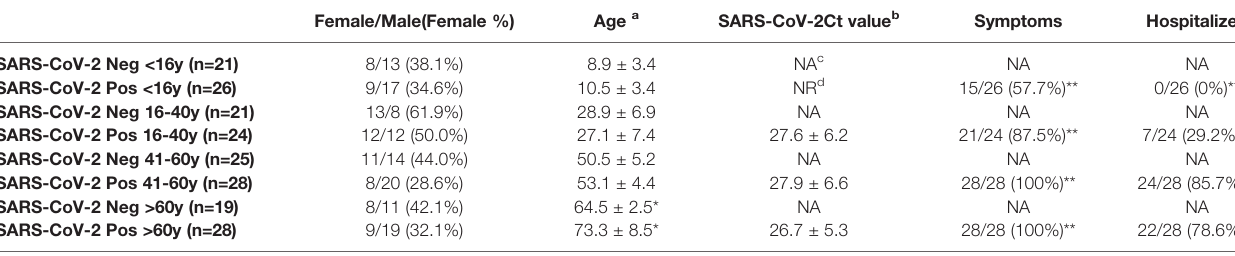
TABLE 1 | Demographic and virologic data of study subjects (N=192) strati fi ed by age